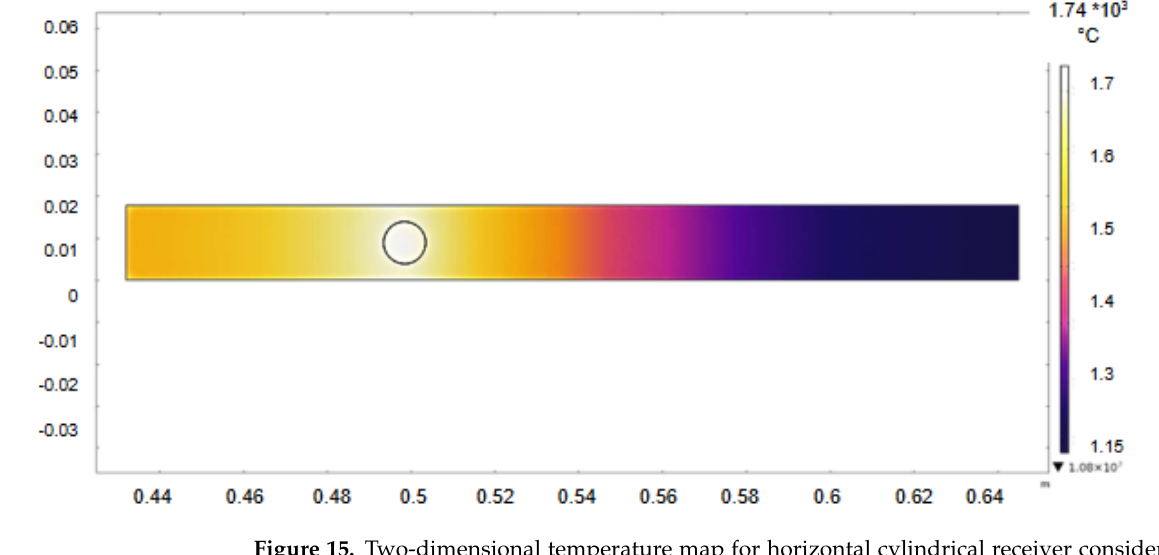
Figure 15. Two-dimensional temperature map for horizontal cylindrical receiver considering the actual exposure of the component to external atmosphere and consequent heat dissipation via convection (steady-state conditions).